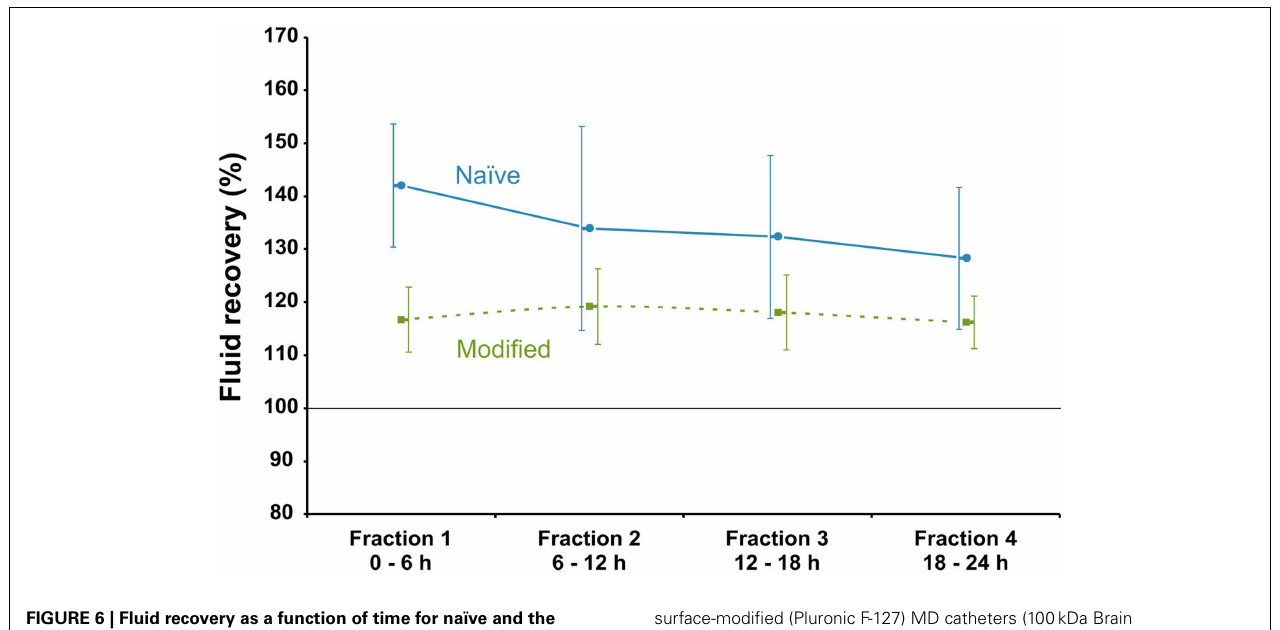
FIGURE 6 | Fluid recovery as a function of time for naïve and the modified MD catheters in vitro . Fluid recovery as a function of fraction order in in vitro microdialysis in human ventricular CSF. Perfusion fluid CNS with 3% w/v Dextran 60 was delivered at 0.3 µ L/min at 37°C. Blue solid line symbolizes naïve MD catheters and green dotted line